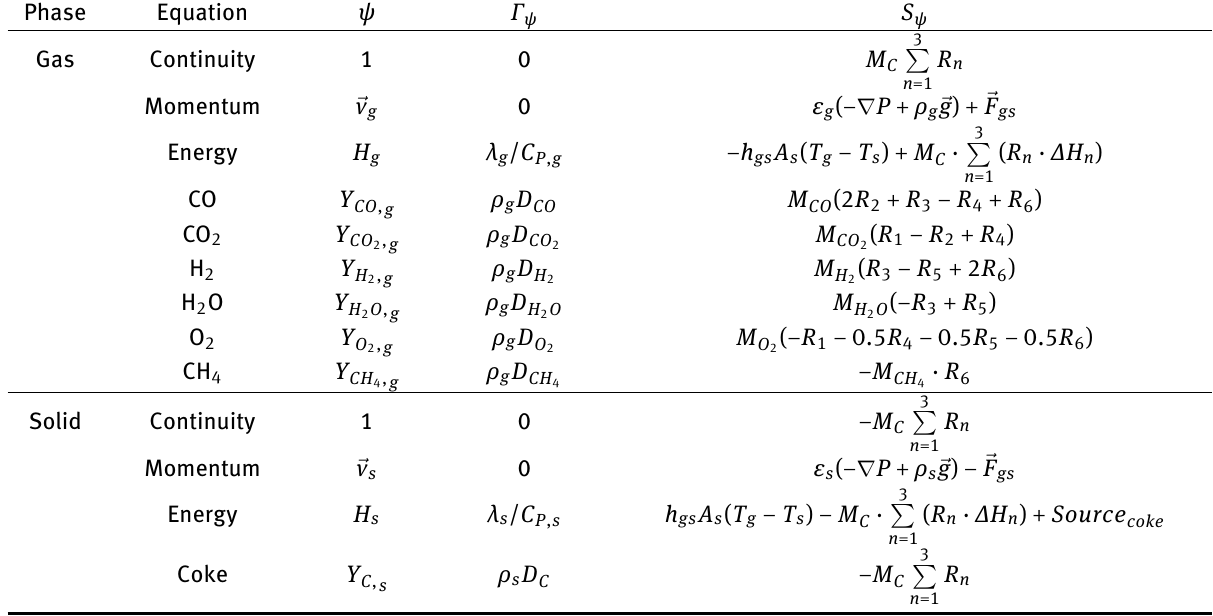
Table 1: Variables considered in Equation 1 Phase Equation Gas